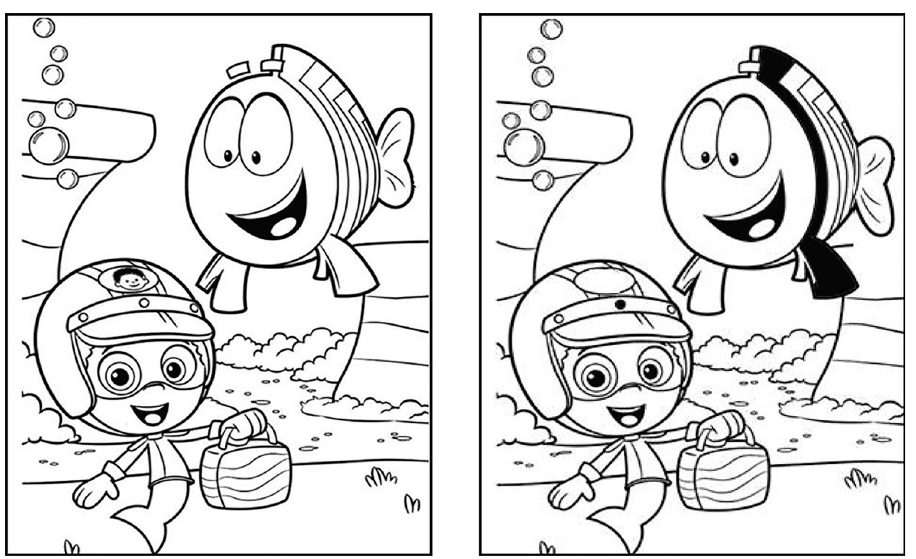
Fig 1. Sample image pair of the spot-the-difference game. This image contains 6 differences (position of bubbles, eye-brow of the larger fish, scale of the larger fish, tail fin orientation of the larger fish, image of face in the helmet of smaller fish and rivet in the helmet of smaller fish) used in Experiment 1. This image pair can be cross-fused using convergence eye movements to create the cyclopean percept and experience the fusion mode of